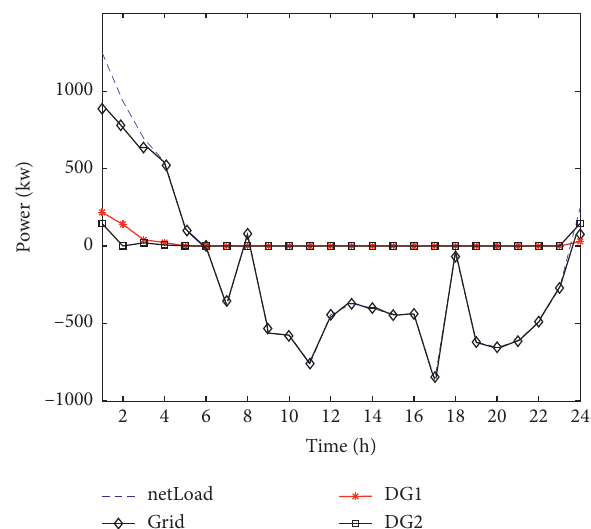
Figure 10: Power output of each unit at the source-grid-load level.